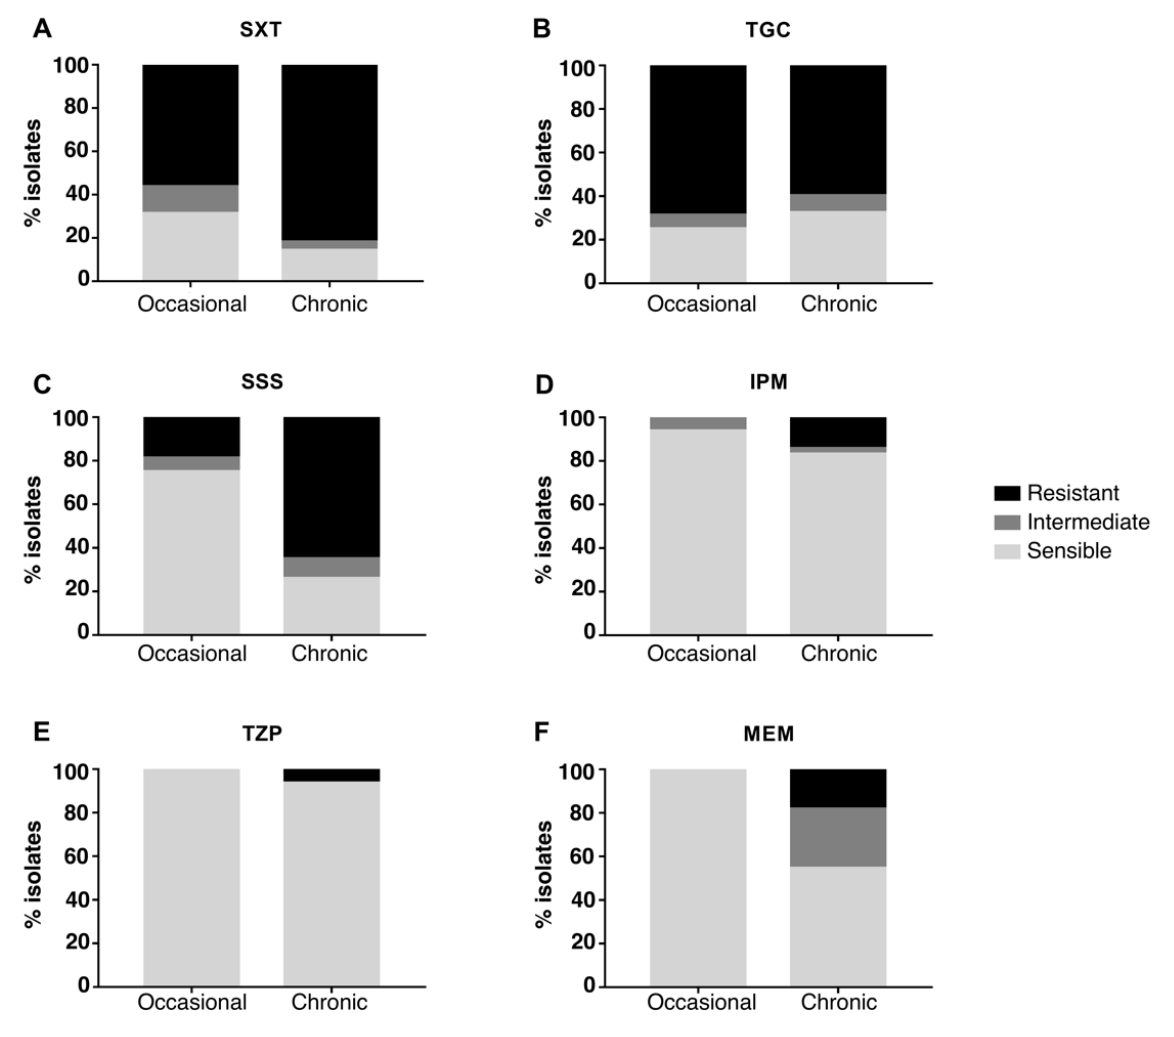
(Figure 4). Antimicrobial susceptibility results per isolate are shown in Figure S3.